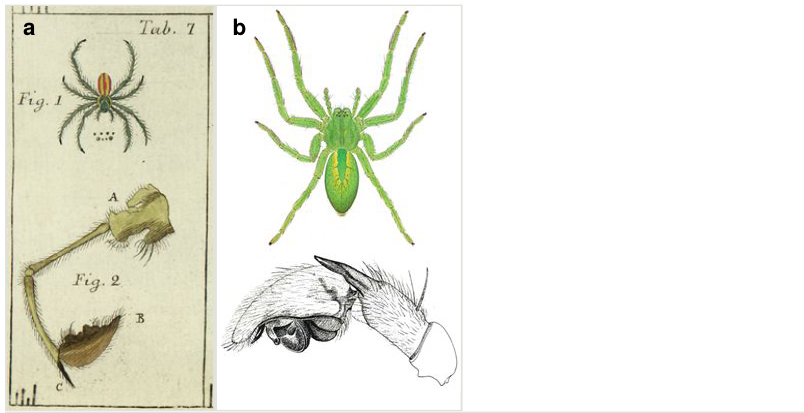
Figure 2. Time series of taxonomic illustrations depicting the spider Micrommata virescens (Arachnida: Araneae: Sparassidae) in standard views.